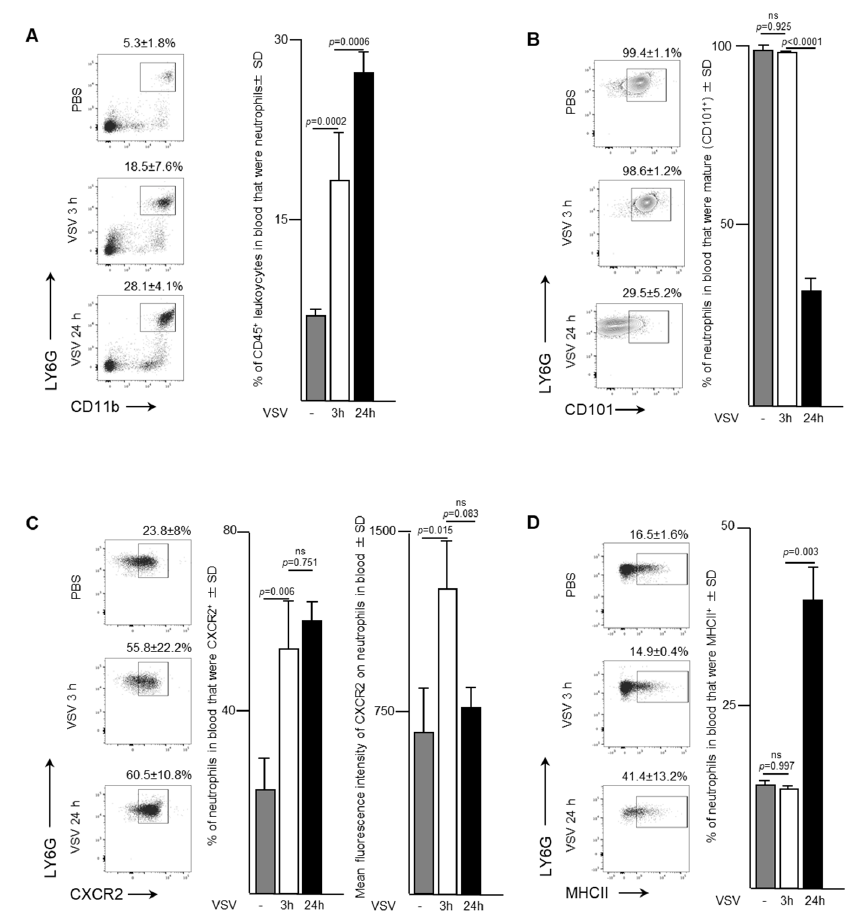
Figure 2. Neutrophils with increased surface density of CXCR2 and inflammatory functions entered the bloodstream in response to administration of vesicular stomatitis virus (VSV). Six- to eight-week-old female C57BL/6 mice were injected intravenously with 1 × 10 9 plaque-forming units of VSV or phosphate-buffed saline (PBS) and euthanized three- or 24-h (h) later. Blood was assessed by flow cytometry to quantify neutrophils. Representative dot plots and graphs with means and standard deviations (SD) ( n = 8/group) are shown for the proportion of ( A ) CD45 + leukocytes that were neutrophils (defined as CD45 + Ly6G hi CD11b hi ), ( B ) neutrophils that were mature (defined by the additional expression of CD101), ( C ) neutrophils expressing the lung-homing chemokine receptor CXCR2, and ( D ) neutrophils expressing the antigen presentation molecule major histocompatibility complex class II (MHCII). (ns = not significantly di ff